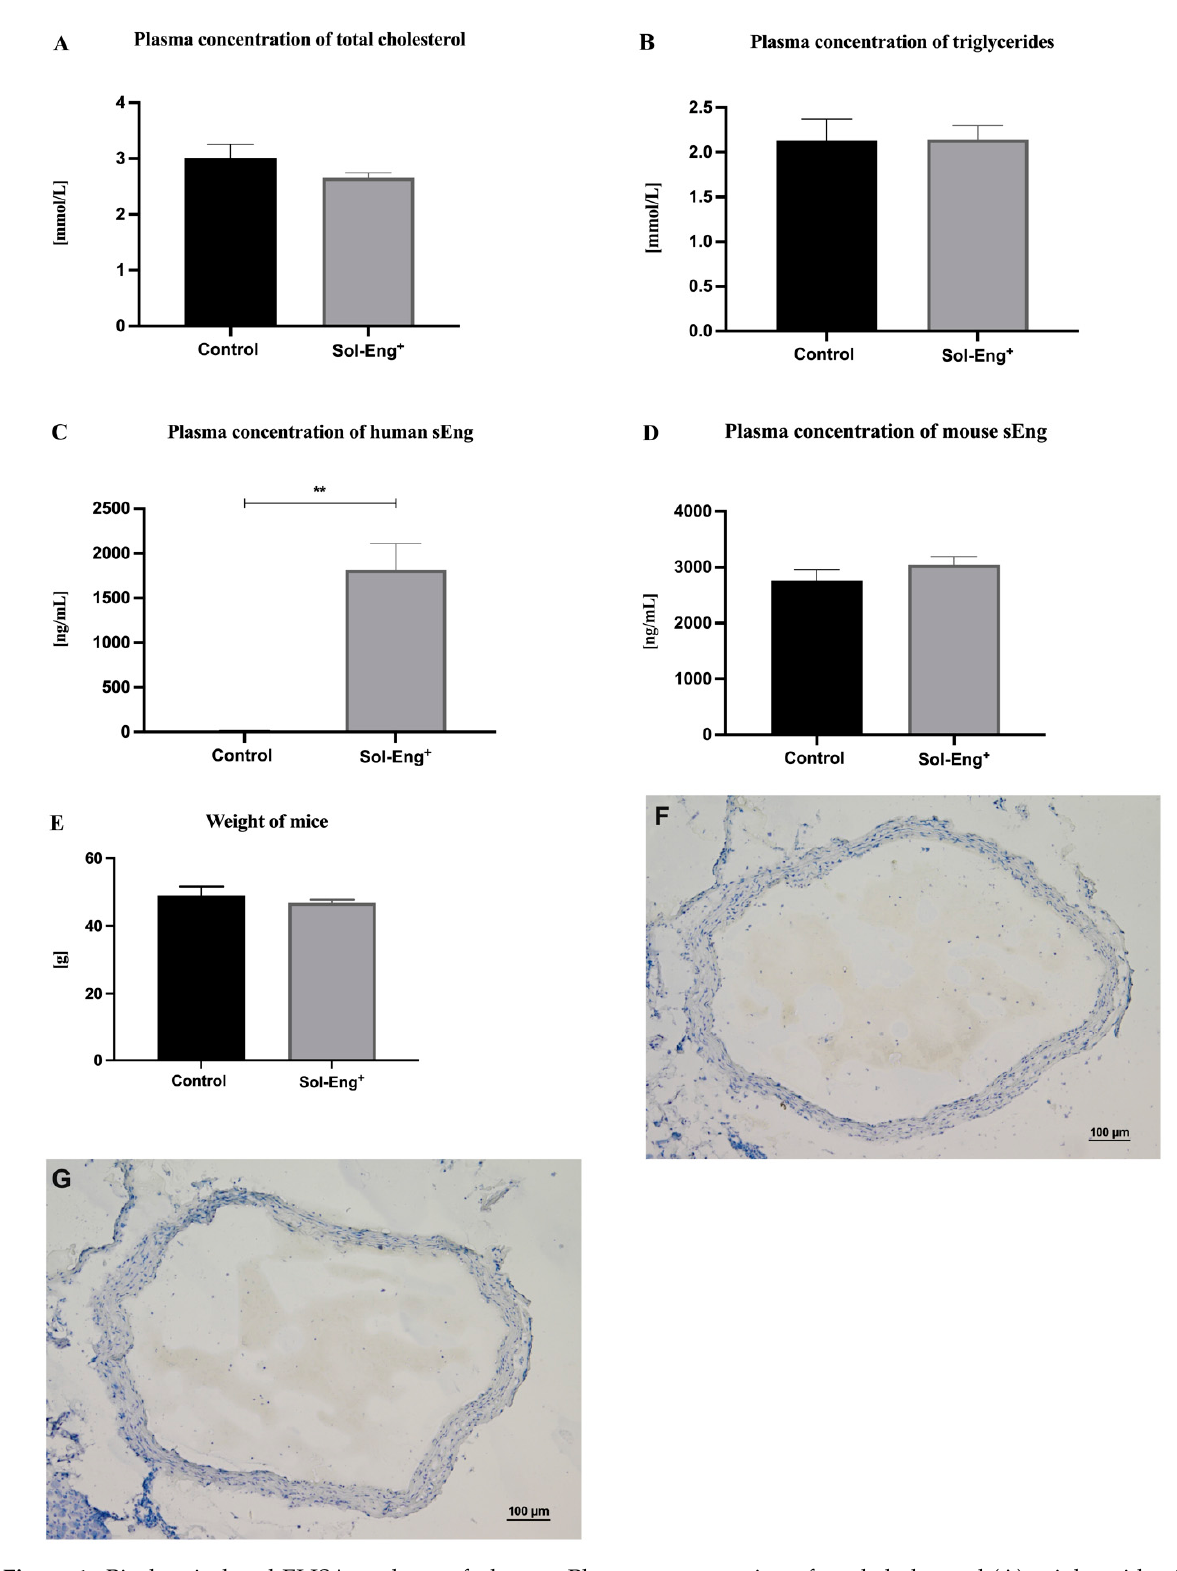
Figure 1. Biochemical and ELISA analyses of plasma. Plasma concentration of total cholesterol ( A ), triglycerides ( B ), human sEng ( C ), mouse sEng ( D ), and weight ( E ) in Sol-Eng + mice and control group. Representative microphotographs of hematoxylin-stained aortas from control group ( F ) and Sol-Eng + ( G ) mice. Data are shown as a mean ± S.E.M., Mann– Whitney test, ** p ≤ 0.01. n = 6 mice per group.